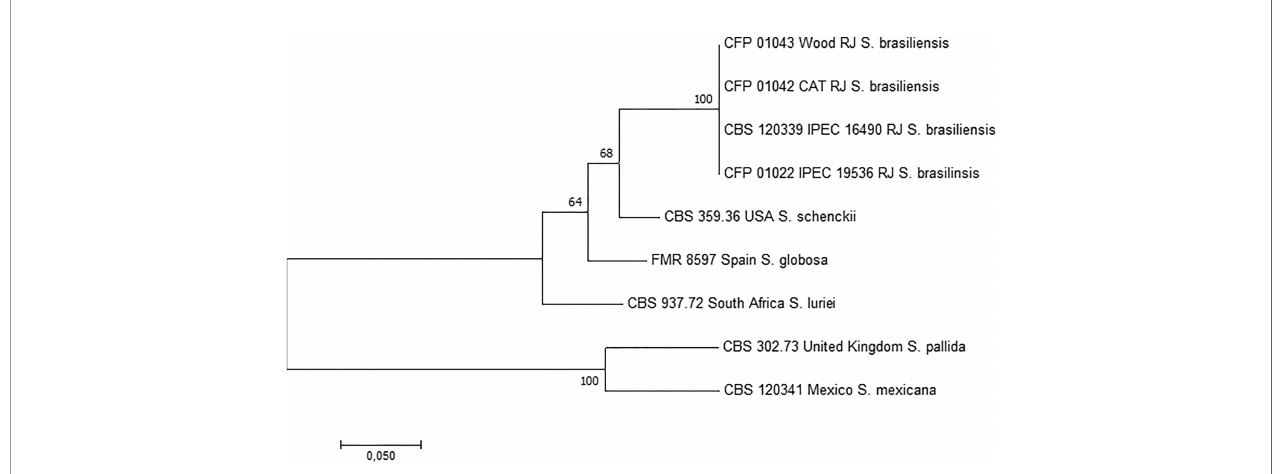
FIGURE 2 | Phylogenetic tree of Sporothrix spp., including the studied S. brasiliensis isolates studied herein, obtained by ML analysis based on partial sequences of the calmodulin, chitin synthase, b -tubulin genes, and internal transcribed spacer (ITS1, 5.8s, ITS2). The 1,000 bootstrap values are represented on the branches. RJ, Rio de Janeiro state, Brazil.